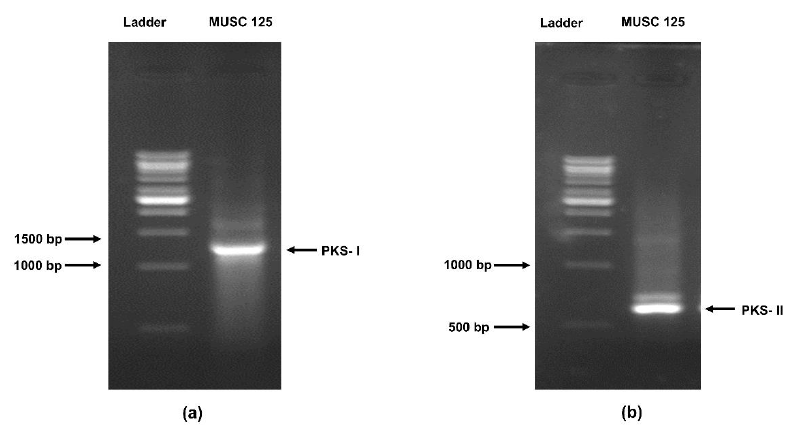
Figure 2. Detection of PCR products in the strain MUSC 125 on agarose gel: ( a ) PKS I (1200–1400 bp) and ( b ) PKS II (600 bp). PKS — Polyketide synthase.